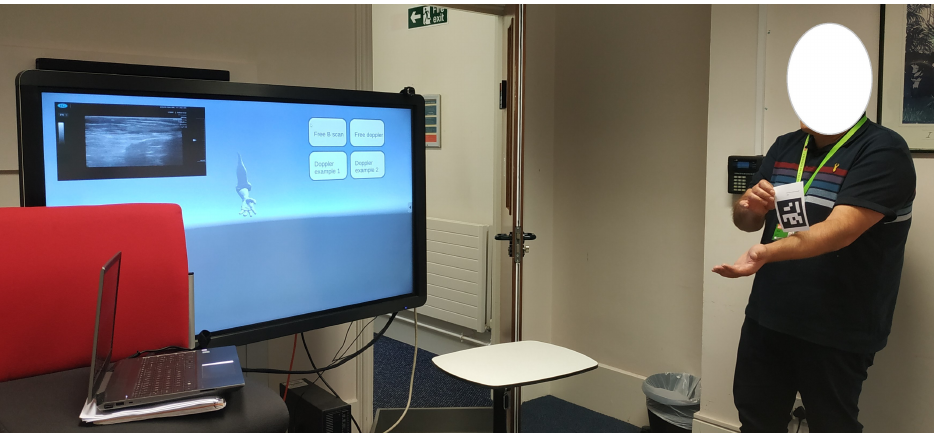
Figure 5. Participant testing the ultrasound training